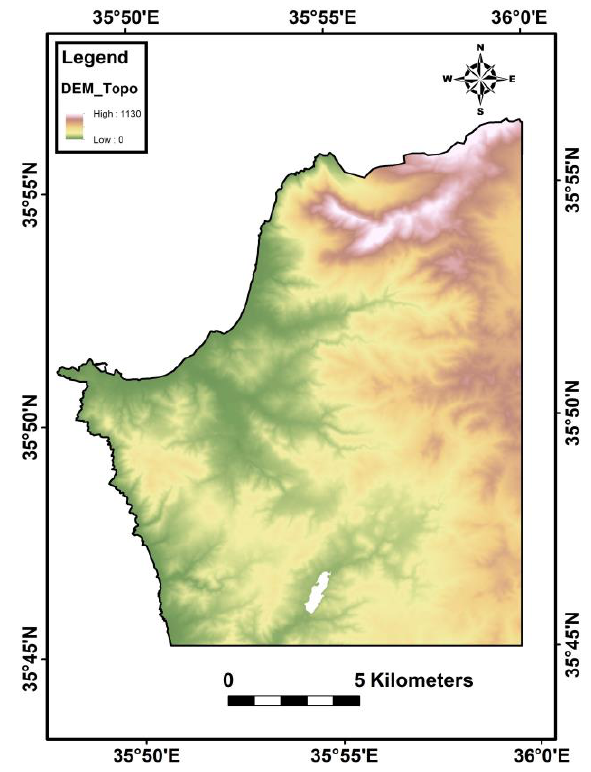
Figure 2. Digital elevation model (DEM) of the study area generated from topographic map